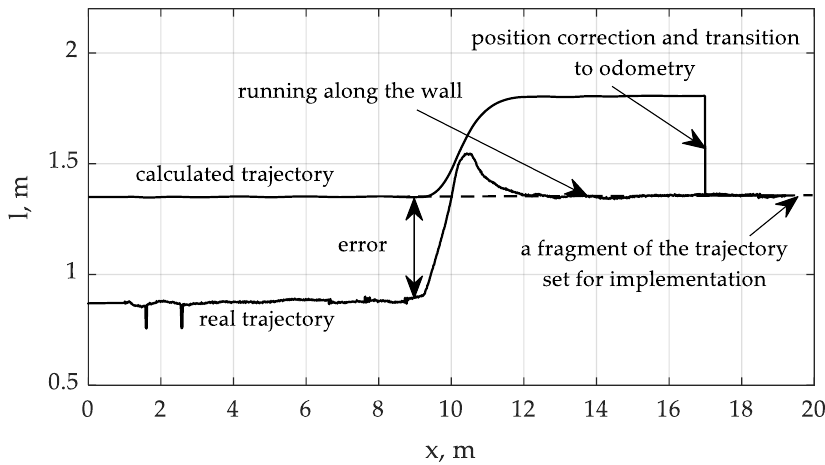
Figure 6. The courses of the real and theoretical trajectories with a parallel position.